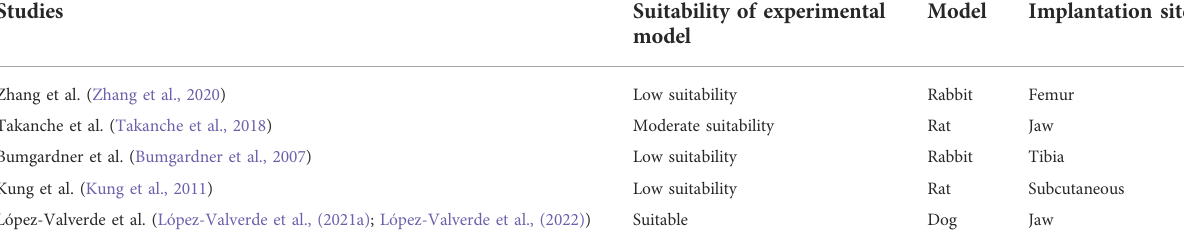
TABLE 3 Suitability of models and implantation sites of in vivo